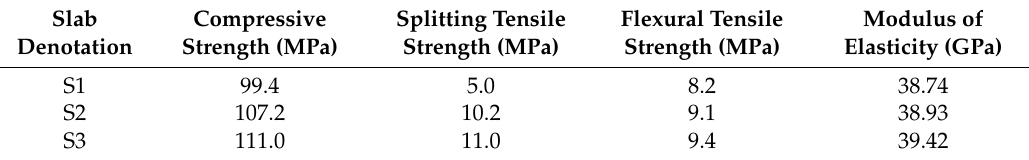
Figure 3. ( a ) Non-contact 3-D deformation measurement system; ( b ) Measurement area of top surface of slab.